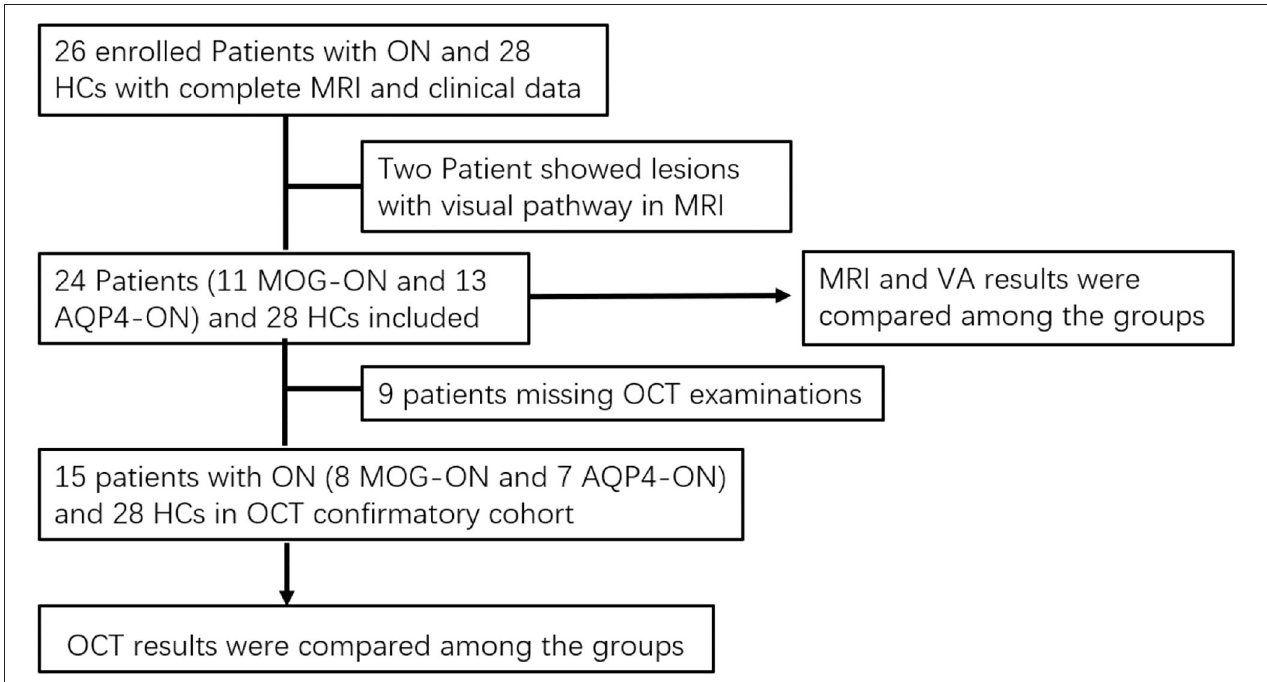
FIGURE 1 | Flowchart of cohort selection. ON, optic neuritis; AQP4, aquaporin-4; MOG, myelin oligodendrocyte glycoprotein; MOG-ON, optic neuritis patients with MOG antibody; MOG-NON, patients with MOG antibody positive without a history of ON; AQP4-ON, NMOSD patients with AQP4 antibody positive and a history of ON; AQP4-NON, NMOSD patients with AQP4 antibody positive but no history of ON; VA, visual acuity; OCT, optical coherence tomography.